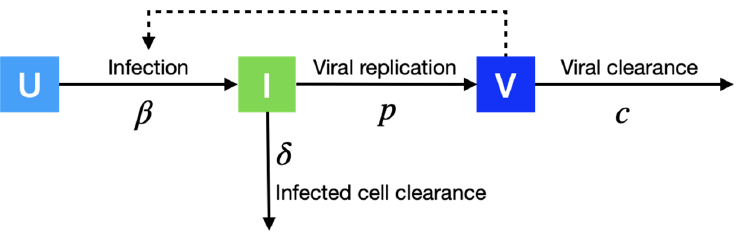
Figure 1. Within ‐ host modeling. We model the replication dynamics of SARS ‐ CoV ‐ 2 viruses within Figure 1. Within-host modeling. We model the replication dynamics of SARS-CoV-2 viruses within an infected individual. Uninfected cells (U) progress to infectious cells (I) with infection rate 𝛽 , and an infected individual. Uninfected cells ( U ) progress to infectious cells ( I ) with infection rate β , and finally release viruses (V) with replication rate p . finally release viruses ( V ) with replication rate p